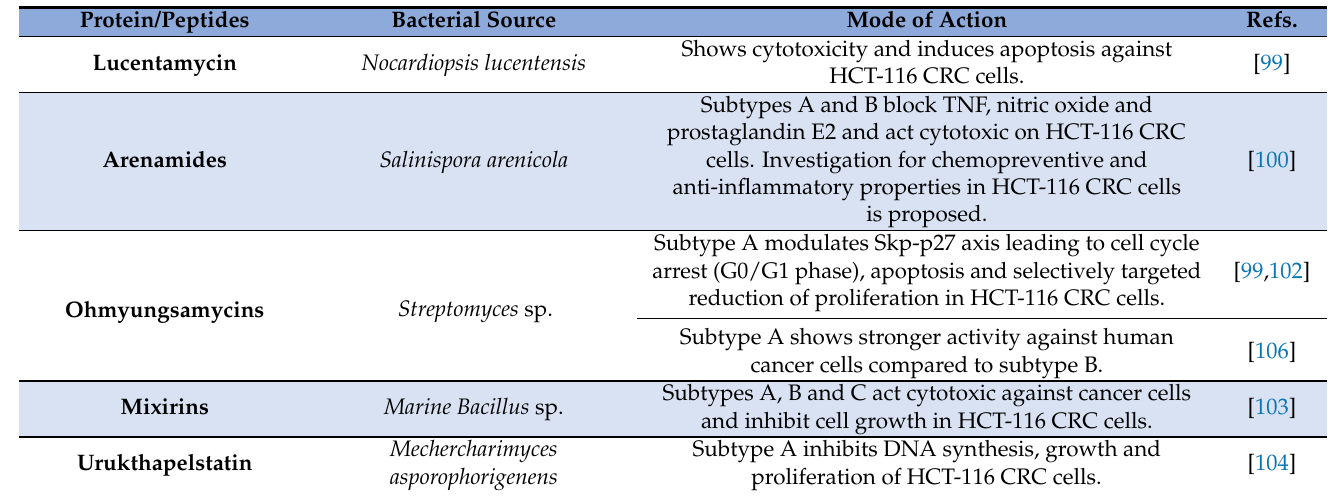
Table 2. Collection of non-ribosomal peptides proposed for CRC